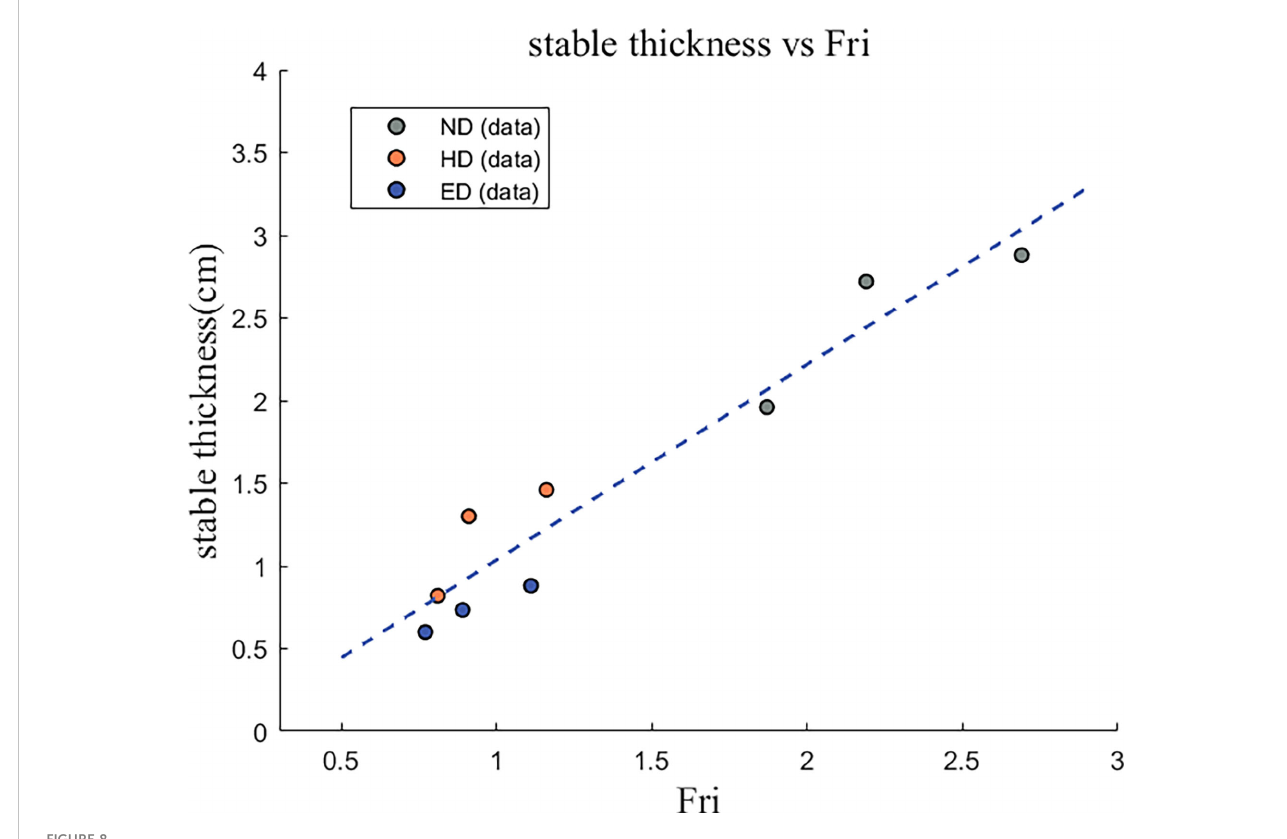
FIGURE 8 The relationship between the stable thickness and the Froude